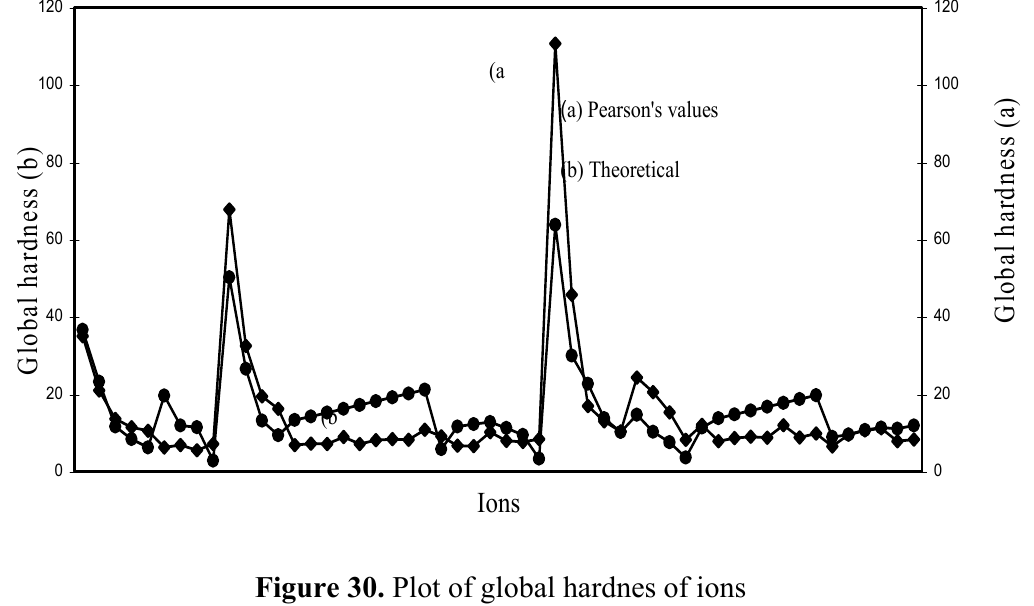
Figure 30. Plot of global hardnes of